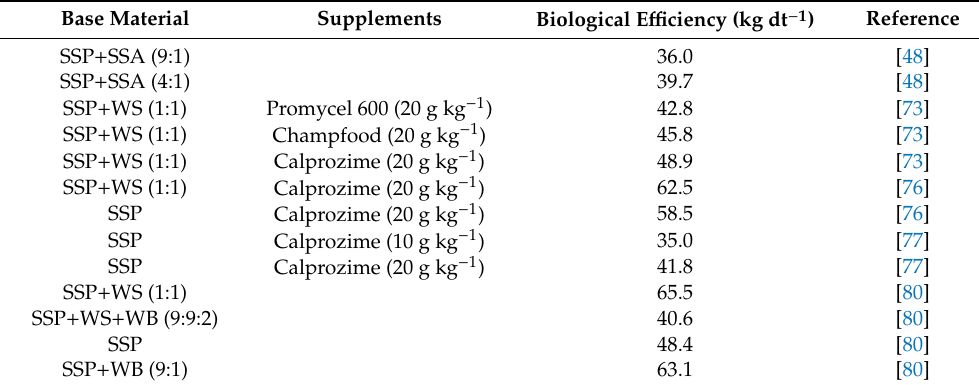
Table 3. Some formulations of new substrates, based on SMSs, for cultivation of Pleurotus ostreatus. Base Material